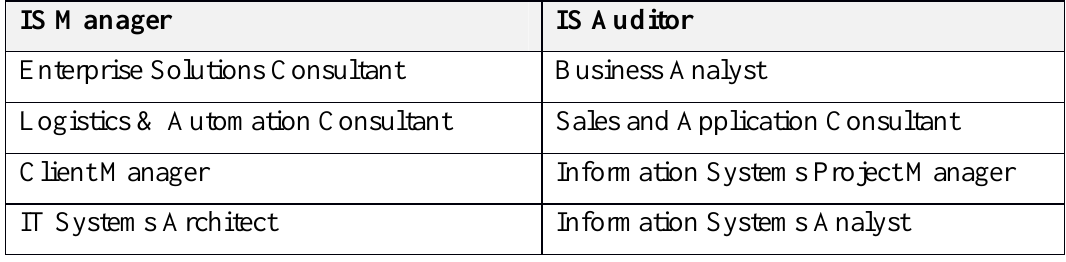
Table 1 – ICT Professionals Roles source: authors, (CEPIS, 2012d) IS